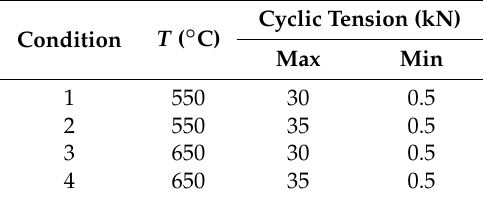
Table 7. Cyclic load conditions for the fatigue tests of the pre-tightened bolt.